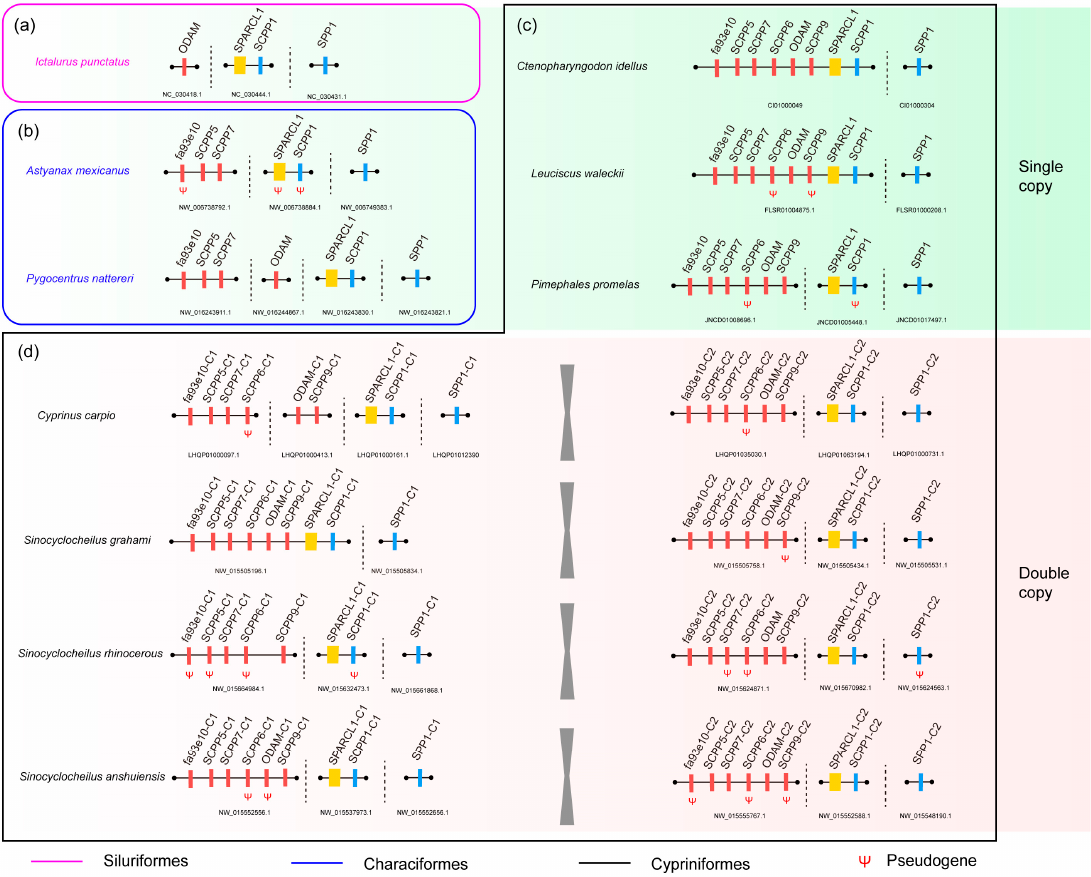
Figure 3. The genomic arrangement of SPARCL1 and SCPP genes in the 10 examined fish genomes. ( a , b , c , d ) Siluriformes, Characiformes, and Cypriniformes fishes, respectively. The yellow, red, and blue colors represent the ancestral SPARCL1 gene, acidic SCPP-encoding genes, and P/Q-rich SCPP-encoding genes, respectively. “ ψ ” stands for possible pseudogenes with missing exons, codon frameshifts, or premature stop codons.